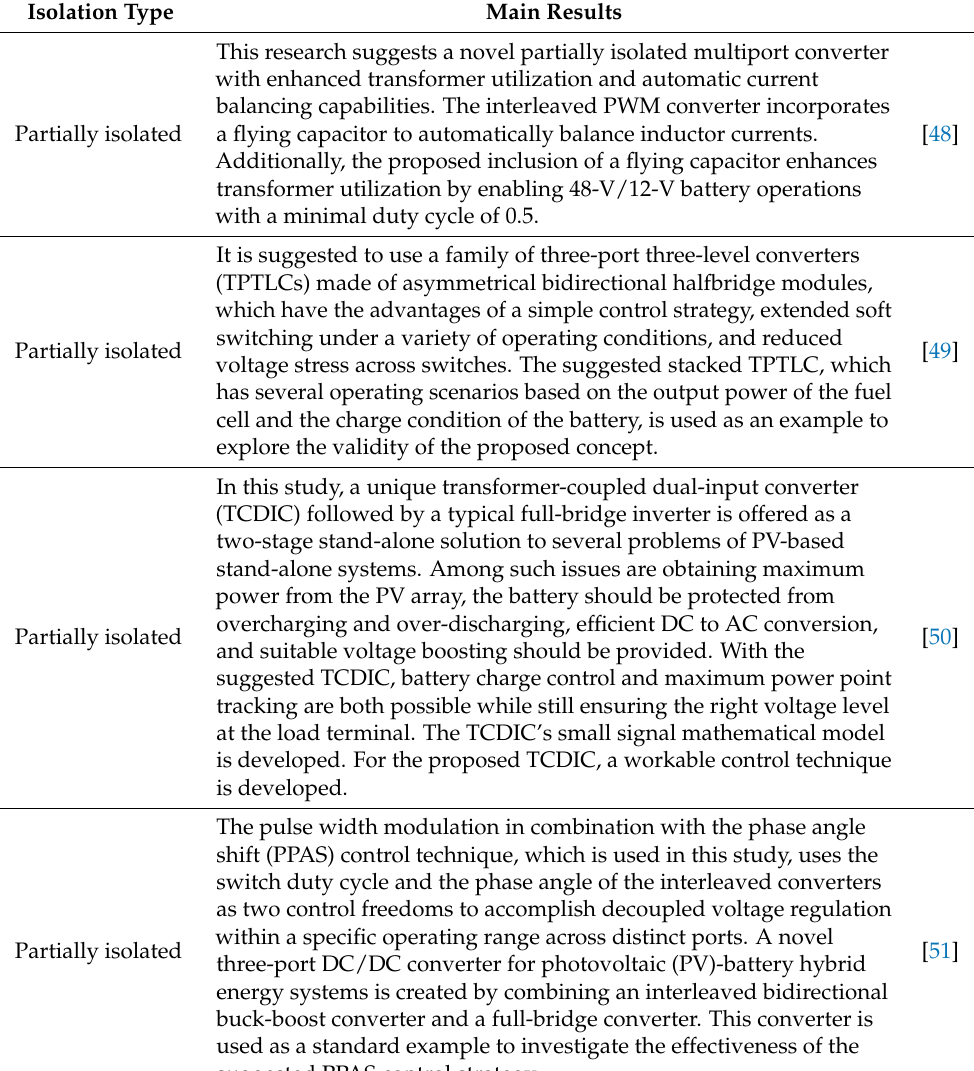
Table 4. Application of different partially isolated MPC topologies for various